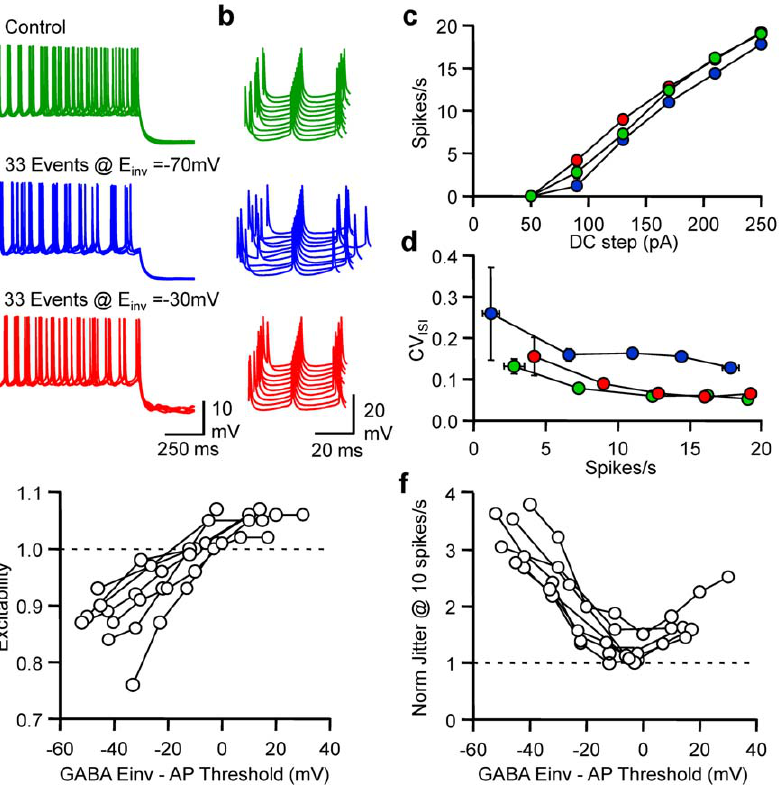
Figure 6. Reversal potential-dependent tuning of pyramidal cell excitability and discharge fidelity. a, Superimposed (5) Vm fluctuations of a whole-cell L2/3 pyramidal neurone in response to a DC step (1 s, 170 pA) in control conditions (green), when 33 randomly occurring GABA A events/s were dynamically injected at E GABA = 2 70 mV (blue) or 2 30 mV (red). Same cell and colour code for b, c and d. b, Waterfall view of Vm when the 5 th spike was set as the time reference. c, Mean firing rate vs DC step. d, CV ISI vs firing rate. e, Normalised changes in excitability observed when neurons received 33 randomly occurring GABA A dynamic currents/s at various differences between E GABA and the calculated threshold for AP in each individual cell (n=9). f, Normalised changes in spike jitter observed for a firing rate of 10 spikes/s. Same conditions as in e.